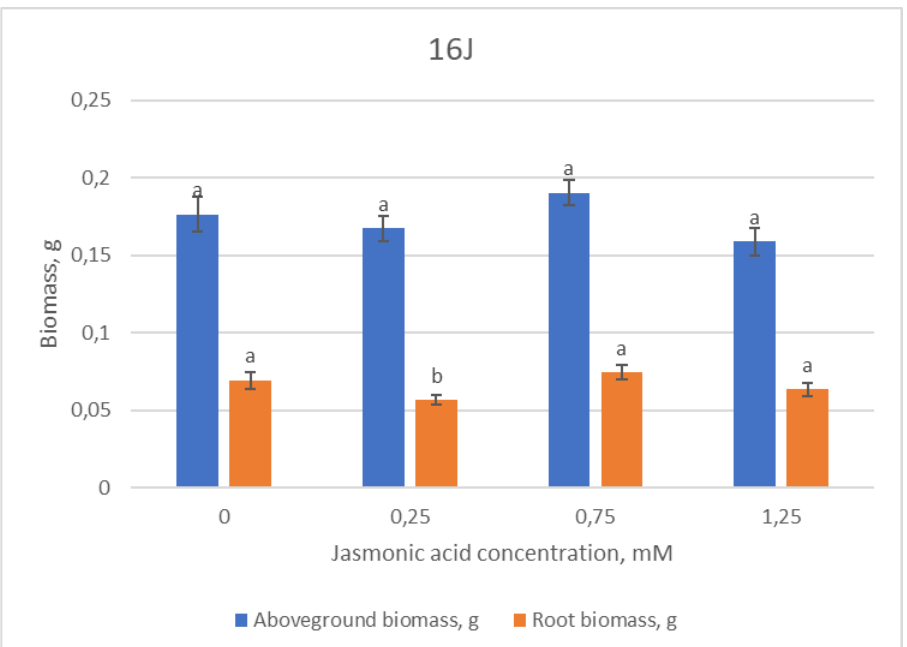
Figure 4. Means (g) ± SE of above-ground and root biomass of Scots pine half-sib family 16J, measured 6 weeks after sowing. Data significance was calculated using the Kruskal–Wallis H test for ranks and post hoc Dunn’s test for pairs ( p < 0.05). Different letters next to different colors indicate significant differences between the groups, sprayed with different concentrations of jasmonic acid.